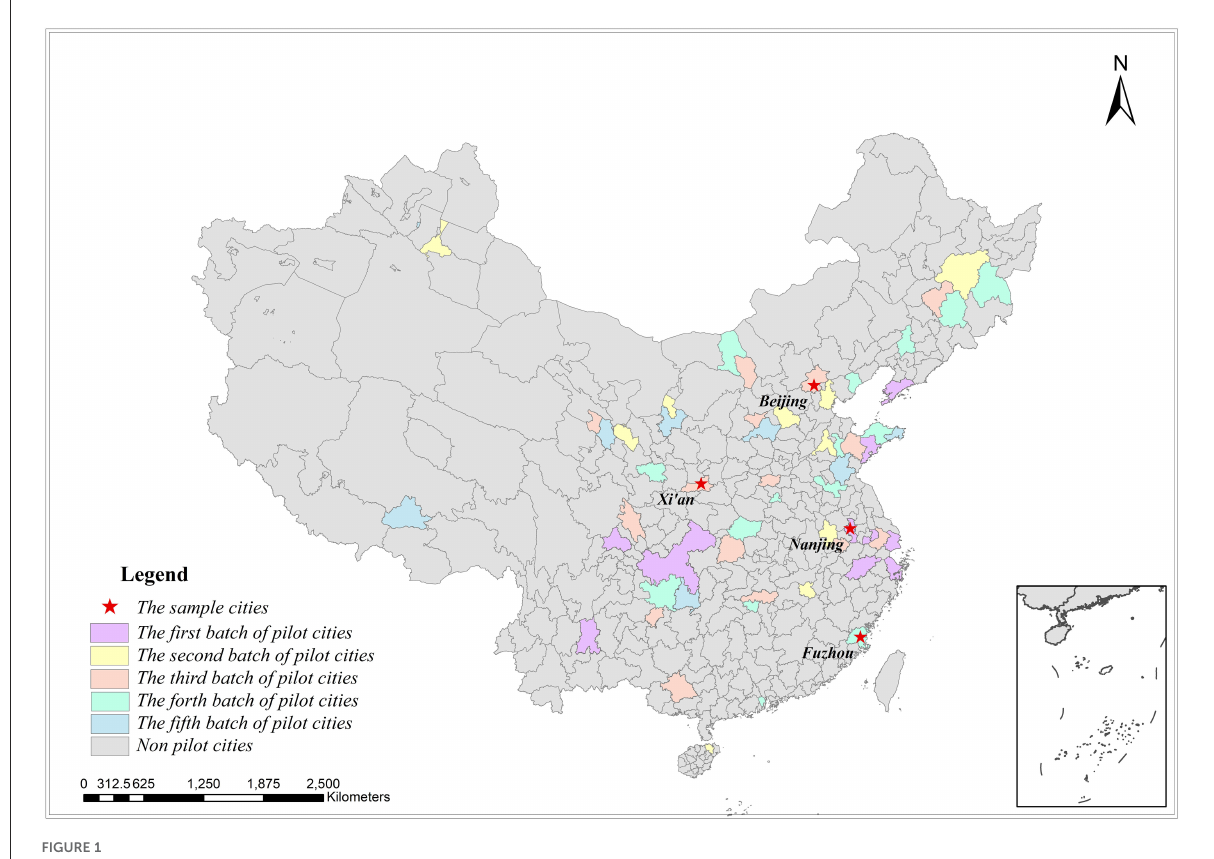
FIGURE1 Maps of the study site.